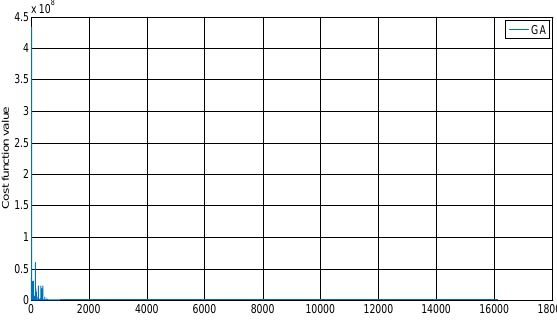
Figure 11. Evolution of fitness value vs. total individuals in GA.